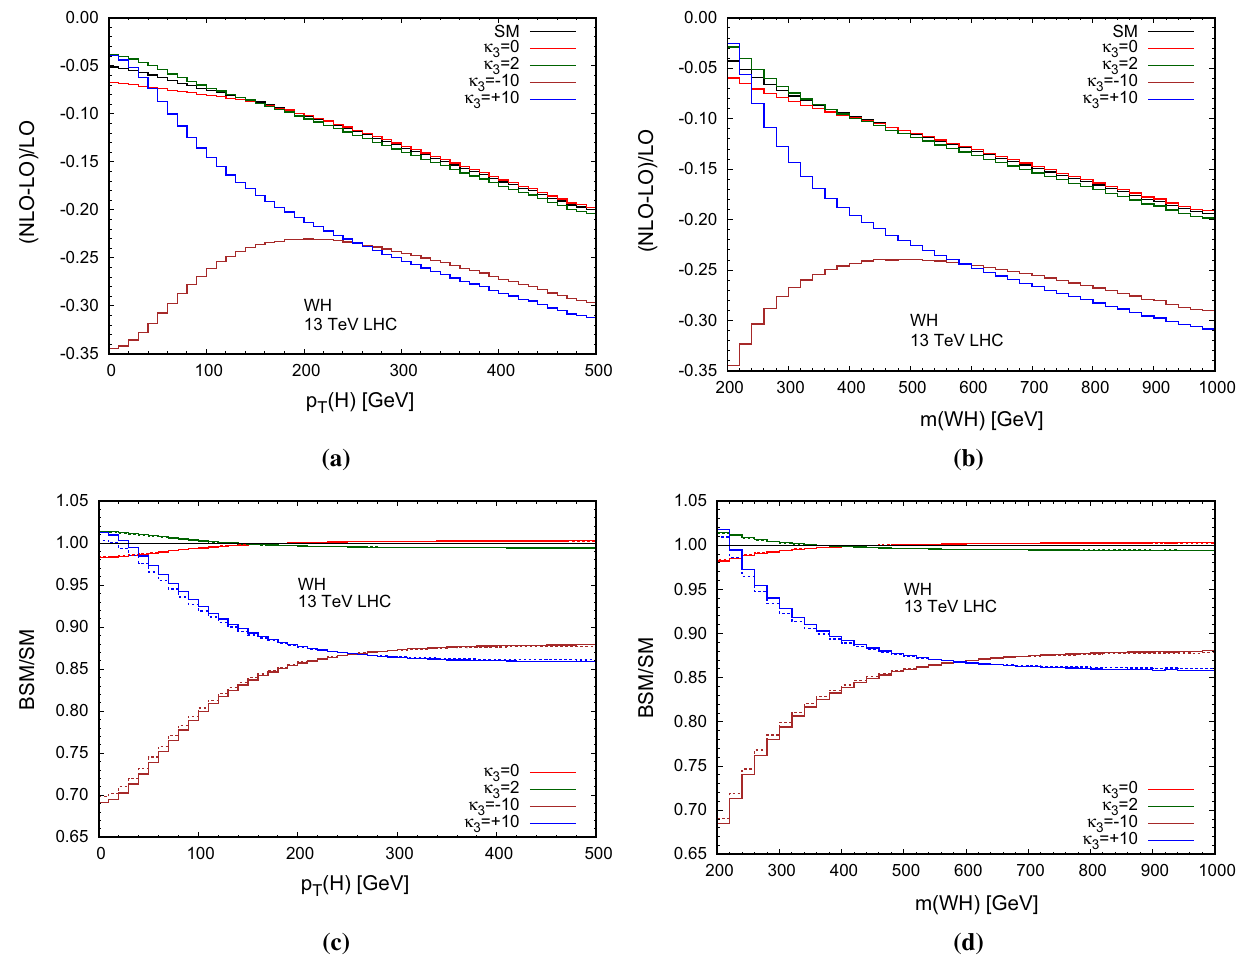
− σ )/σ LO LO ratio for different values of NLO